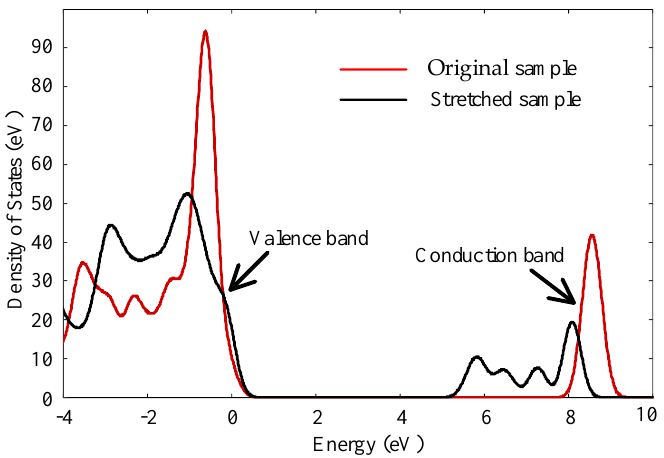
Figure 15. Density of states diagram before and after stretching.